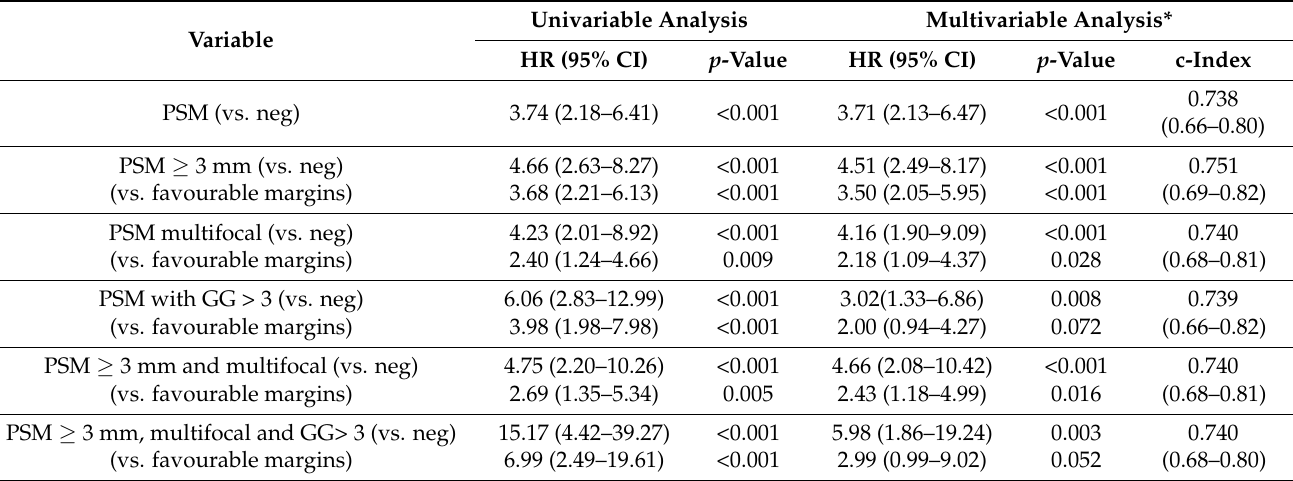
Table 3. Univariable and multivariable* Cox regression models predicting biochemical recurrence af- ter RARP and the role of PSM and their adverse characteristics. Multivariable models’ discrimination with optimism-corrected c-indices are